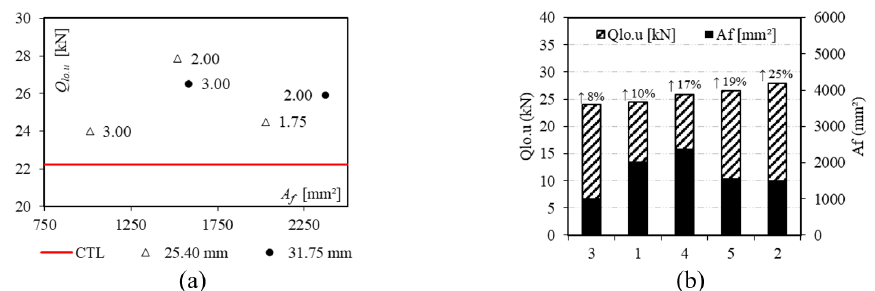
Figure 18. Relation between (a) the ultimate load by the total area of holes, for each hole diameter; (b) ultimate load increase for each specimen type, and the total area of holes, in relation to the control